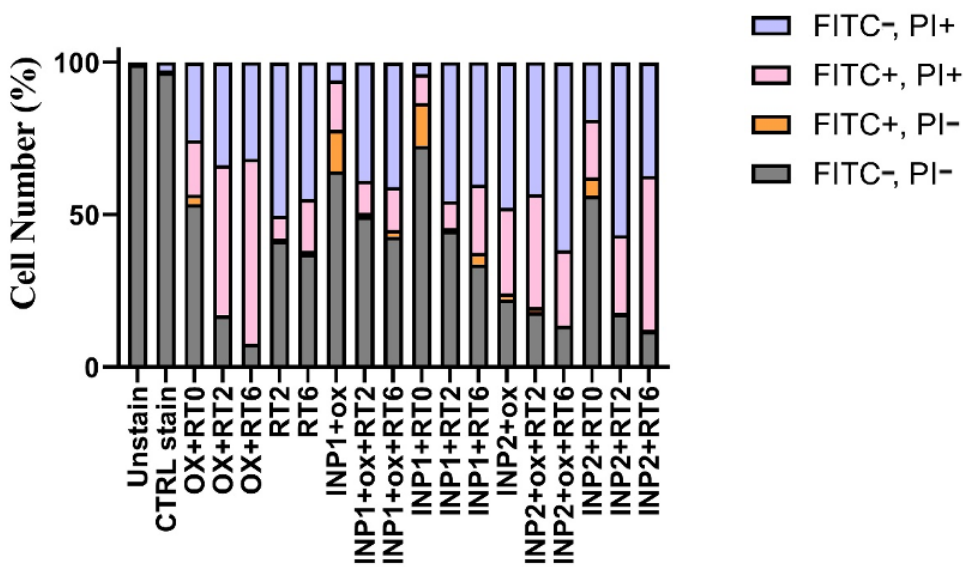
Figure 7. Quantitative results of apoptotic effects evaluated by Annexin V/FITC assay. Abbrevia- tions: INP1, iodine nanoparticle 1. INP2, iodine nanoparticle 2. 0, Radiotherapy at 0 Gy. 2, Radio- therapy at 2 Gy. 6, Radiotherapy at 6 Gy. OX, Oxaliplatin.